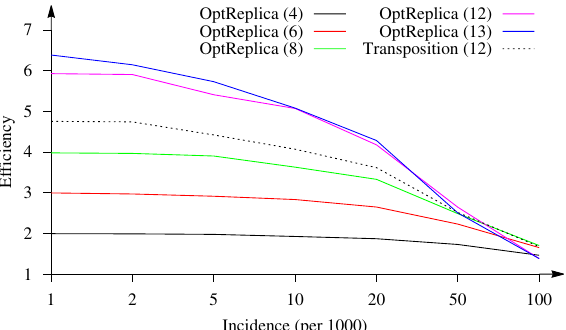
Figure 3. Dependence of the efficiency of OptReplica with different pool sizes and the transposition based replication on the incidence of the disease testing 96 samples.